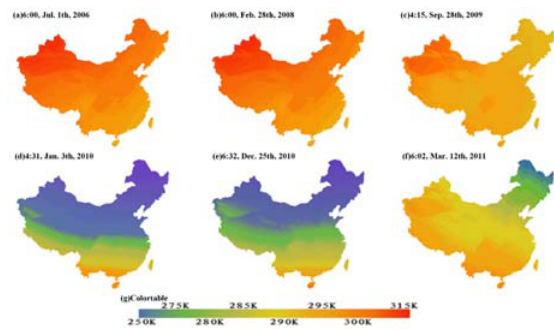
Figure 7. The contrast analysis between calculated (SC) and Remote Sensing observations (RS) brightness temperatures